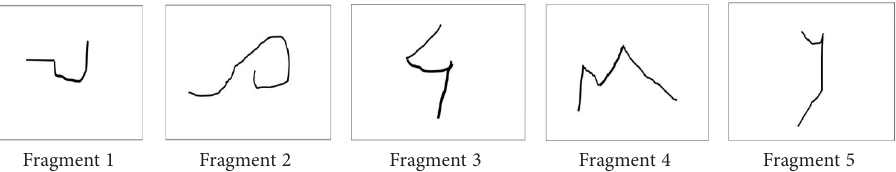
Figure 1. The creative tasks: Fragments 1 to 5 (source: testingmom.com, 2020)